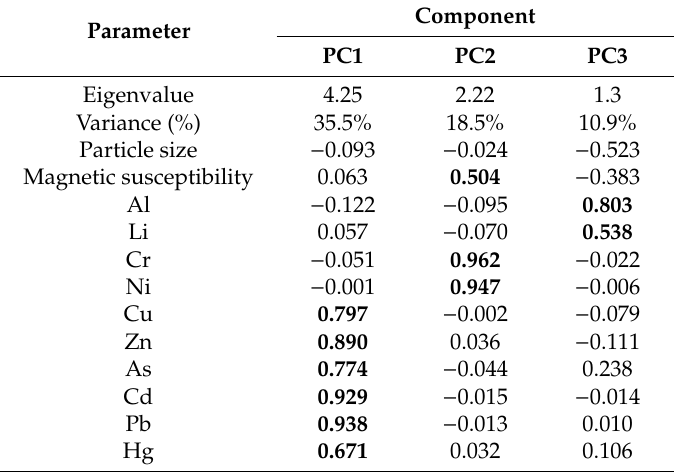
Table 2. Principal component factor scores and eigenvalues of the measured parameter of this study. The results of the principal component analysis (PCA) (PCA loadings > 0.5) are shown in